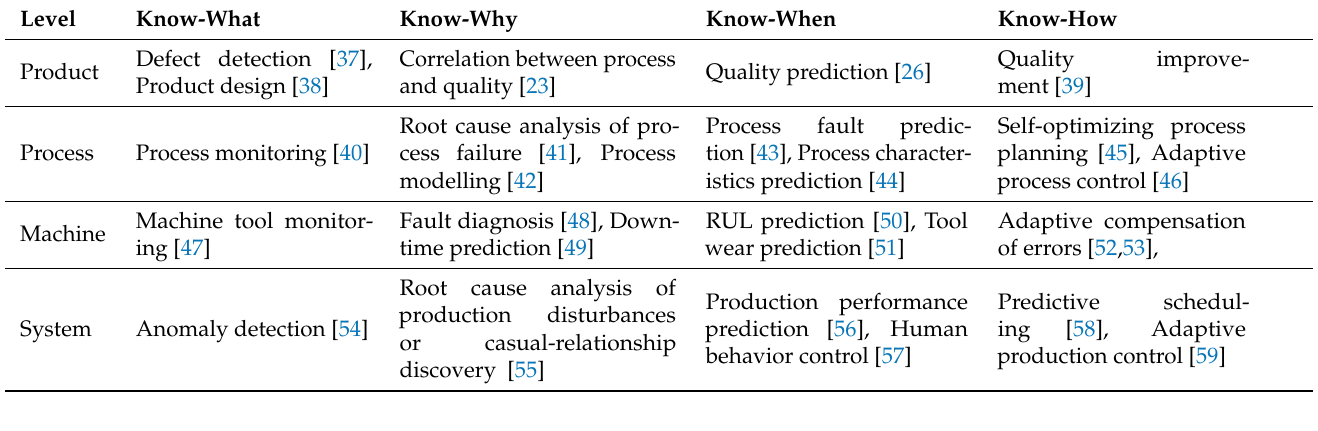
Table 1. Typical ML use cases categorized by Four-Level and Four-Know.